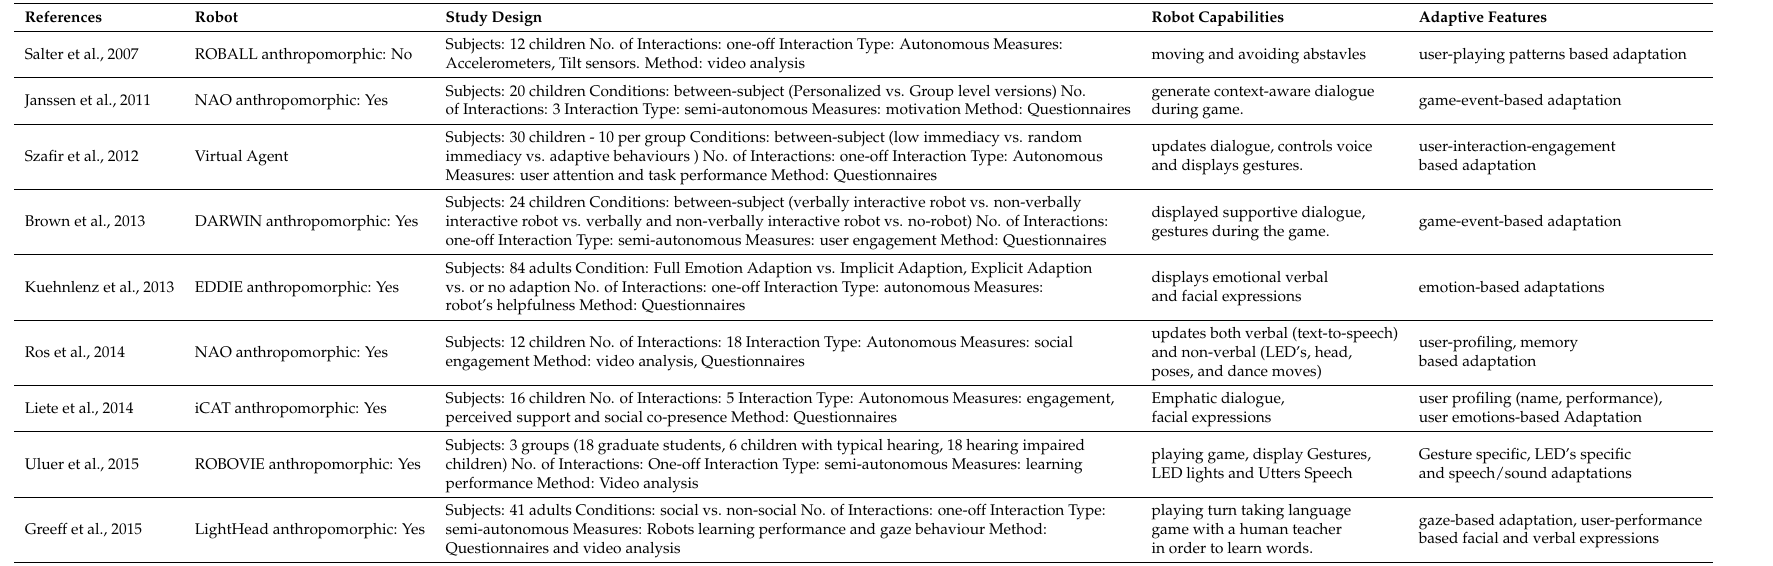
Table 2. Summary of Adaptive Interaction studies in Education